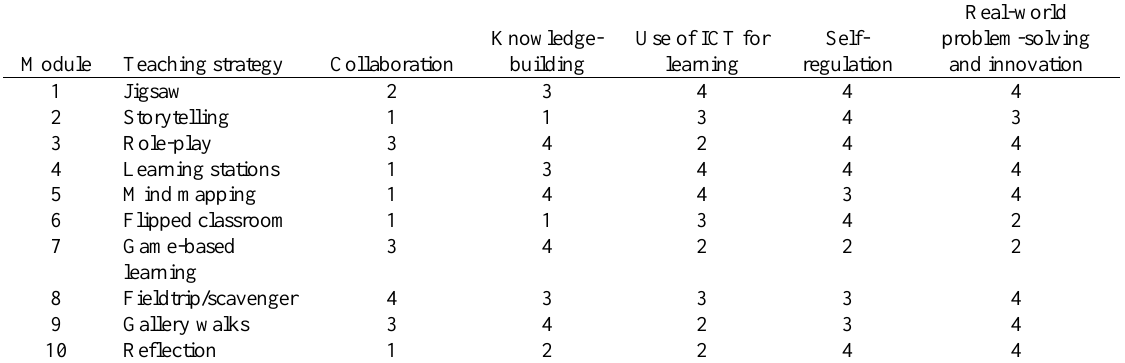
Table 3 Evaluation result of the 21st Century Learning Design Rubrics. Implementation of the Microsoft Partners in Learning